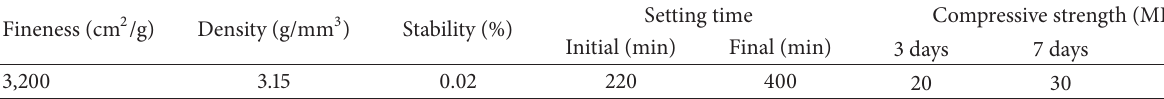
Table 1: Properties of cement.